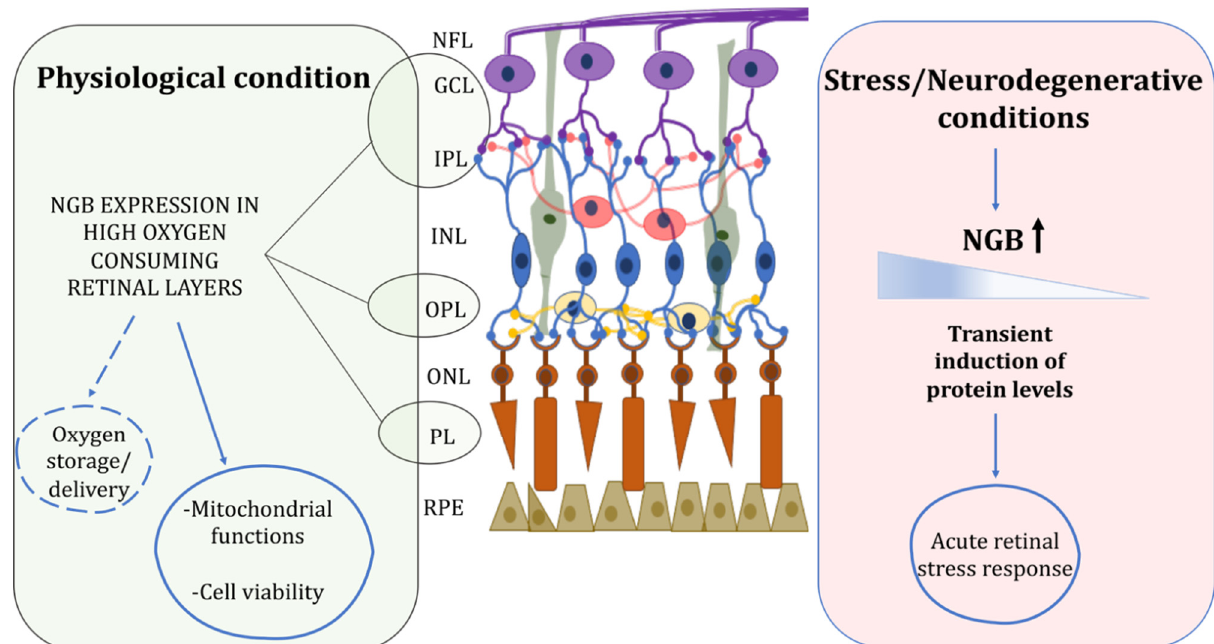
Figure 1. Schematic representation of retinal NGB distribution and proposed functions under physiological and stress/neurodegenerative conditions. In physiological condition, NGB is mainly expressed in high oxygen consuming retinal layers where it could function for oxygen storage/delivery and preservation of mitochondrial functionality and cell viability. Under stress injury, NGB protein levels are transiently induced in retina layers suggesting a role of the globin in the acute stress response. For details, see the text. Retinal pigment epithelium (RPE), photoreceptor layer (PL), outer nuclear layer (ONL), outer plexiform layer (OPL), inner nuclear layer (INL), inner plexiform layer (IPL), ganglion cell layer (GCL), nerve fiber layer (NFL). Dotted lines represent not yet clarified functions.